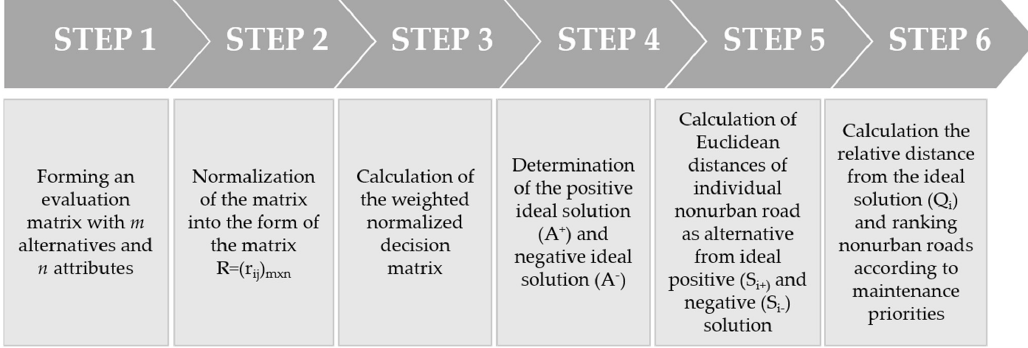
Figure 6. Concept of sub − model of nonurban road priority ranking.